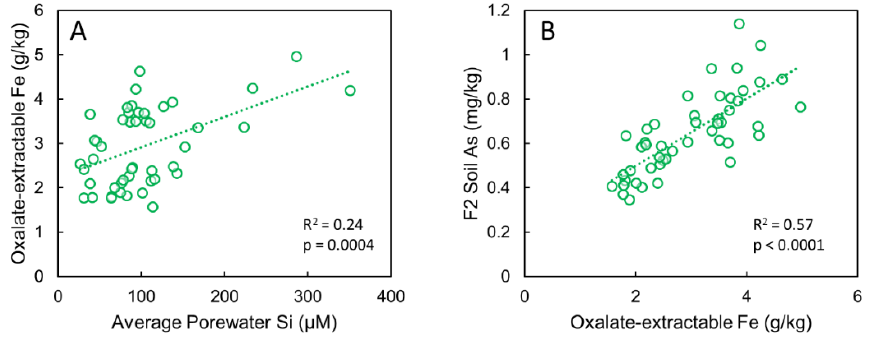
Figure 8. Relations between ( A ) oxalate-extractable Fe and porewater Si and ( B ) F2 soil As and oxalate-extractable Fe from the field study.